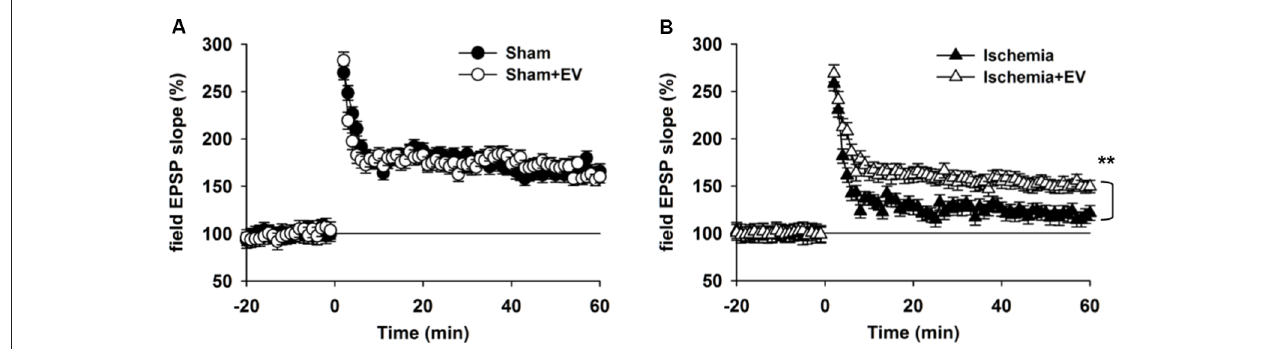
FIGURE 4 | BMSC-EVs rescues impaired hippocampal long-term potentiation (LTP) in mice subjected to global ischemia. (A) LTP was induced by high frequency stimulation (HFS, two trains at 100 Hz for 1 s, separated by 10 s) in acute hippocampal slices prepared from mice 1 day after surgery. (A) EV treatment did not notably alter LTP in sham-operated mice (mean of the last 10 min: sham = 165 ± 8.1% and sham + EV = 162 ± 6.9%). (B) Global ischemia largely impaired LTP 1 day days after reperfusion. EV treatment significantly prevented the reduction of the mean amplitude of the last 10 min of the recordings (ischemia = 121 ± 8.3% and ischemia + EV = 162 ± 7.9%). n = 10 slices from 5 mice per group. Data show means ± SEM. Student’s t -test. ∗∗ p <